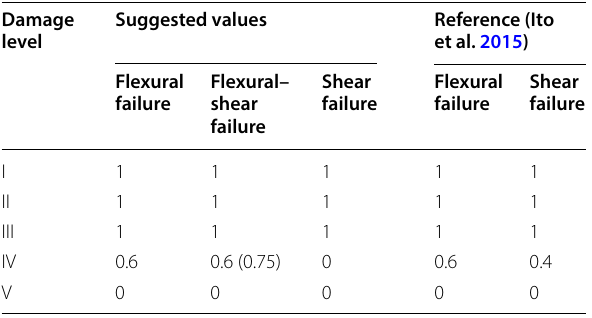
Table 10 Suggested reduction factors of strength for RC column members.